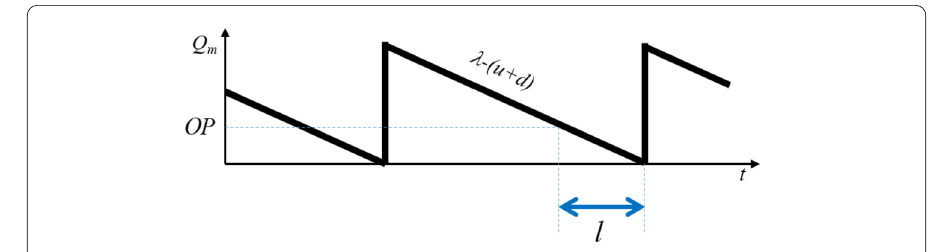
Figure 5 Stock quantity across time, lead time, and order point for Model